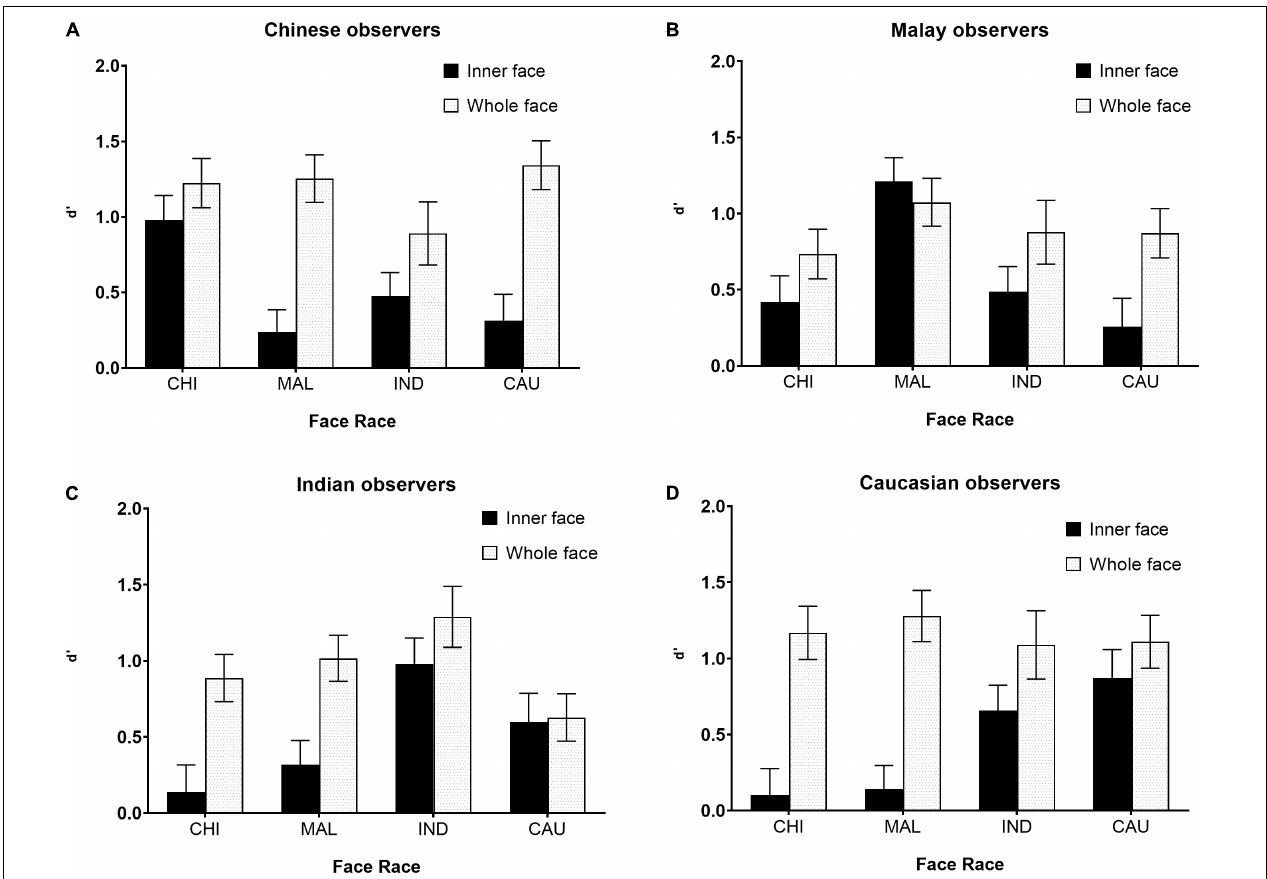
FIGURE 4 | d (cid:48) for Chinese, Malay, Indian, and Caucasian faces in Chinese (A) , Malay (B) , Indian (C) , and Caucasian (D) participants in the recognition task. Face recognition was impaired for face images without external features. Surprisingly, however, the absence of external features led to a greater decline in the participants’ ability to recognize other-race faces. Error bars represent standard error of the